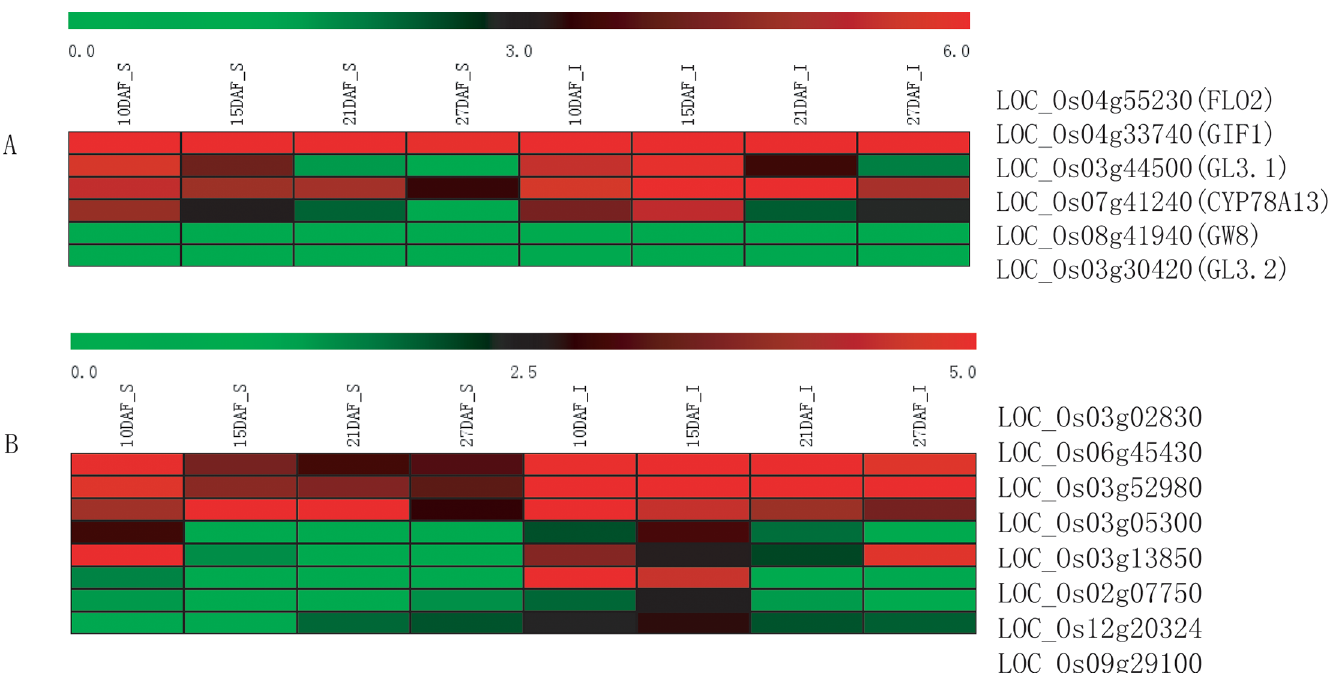
Fig 4. Heat map representation of grain size controlling and cell cycle related genes. “ A ” indicates grain size controlling genes expression. “ B ” indicates cell cycle related genes expression. “ DAF ” indicates day after flowering. “ S ” indicates superior grains, and “ I ” indicates inferior grains. Expression of genes (in TPM) was subjected to log2 conversion. With those zero expression genes, zero was converted with 0.01(in TPM).